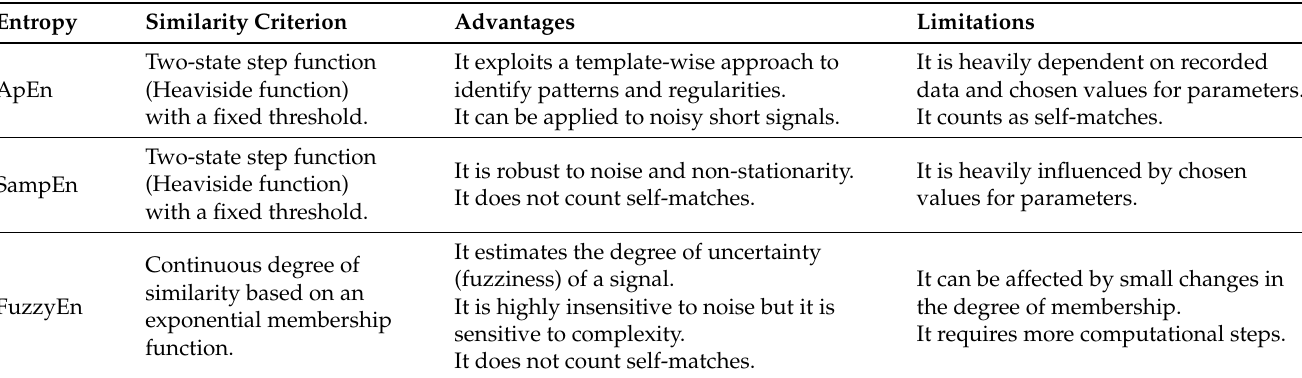
Table 1. Advantages and limitations of the three formulations of single-scale